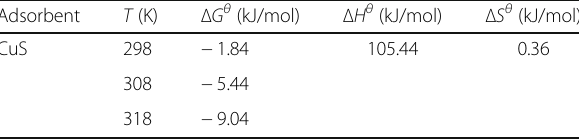
Table 3 Thermodynamic fitting parameters of copper